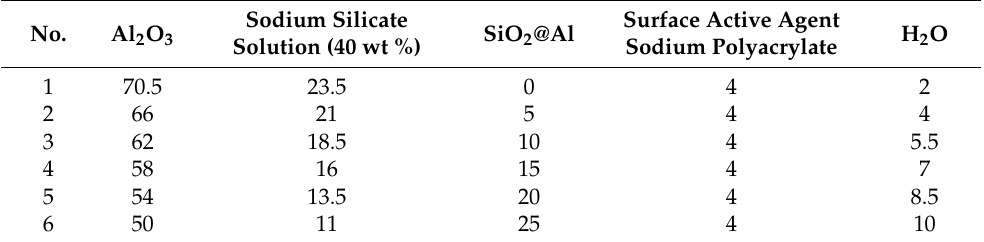
Table 1. The composition of the ceramic coating (wt %).